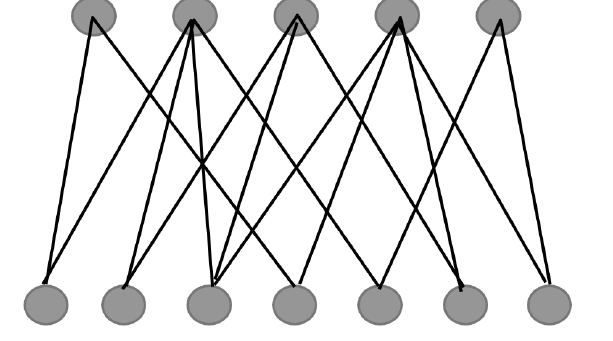
Fig. 3 . Graphical illustration of multiple hierarchical arrangements comprising a heterarchy.